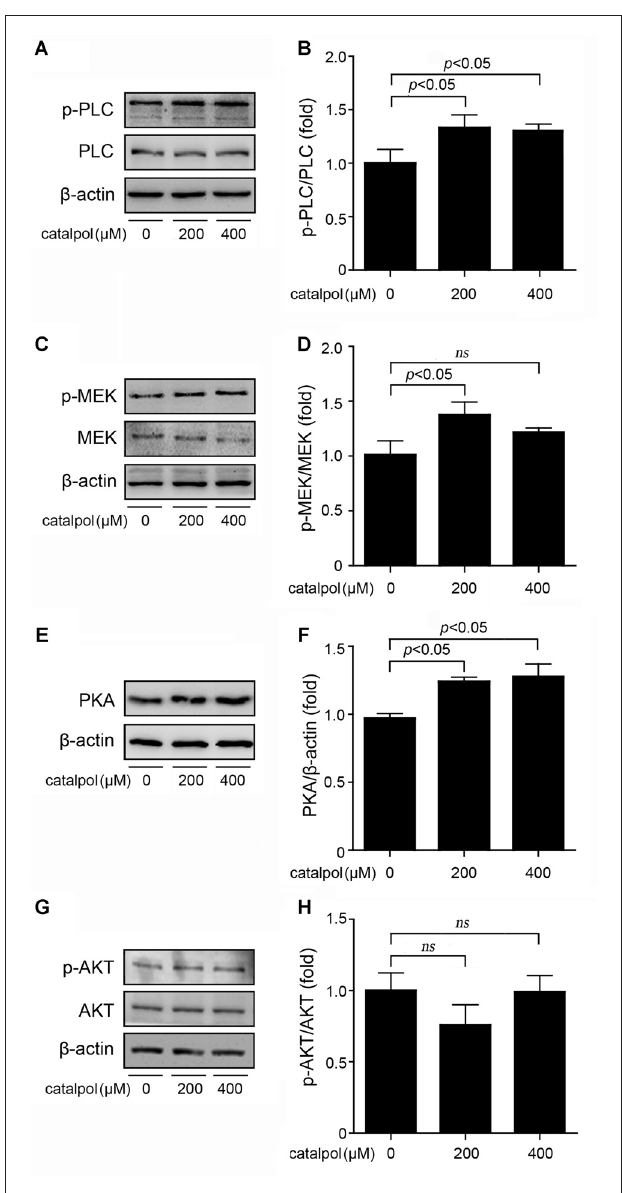
FIGURE 5 | Effects of catalpol on the upstream proteins of CREB signaling pathway. (A–D) SweAPP N2a cells were treated with catalpol for 1 h. (A,C) Immunoblotting analyses and (B,D) quantifications showing the phosphorylation levels of phospholipase C (PLC) and mitogen-activated extracellular signal-regulated kinase (MEK) markedly increased in cells treated with 200 µ M catalpol. (E) Immunoblotting analyses and (F) quantification show that treatments with catalpol at the concentration of 200 µ M and 400 µ M significantly increased the protein levels of protein kinase A (PKA). (G) Immunoblotting analyses and (H) quantification showed no significant changes of AKT phosphorylation levels could be detected in catalpol-treated cells compared with vehicle control cells. The data are expressed as the mean ± SEM. n = 3. The p values were calculated using one-way